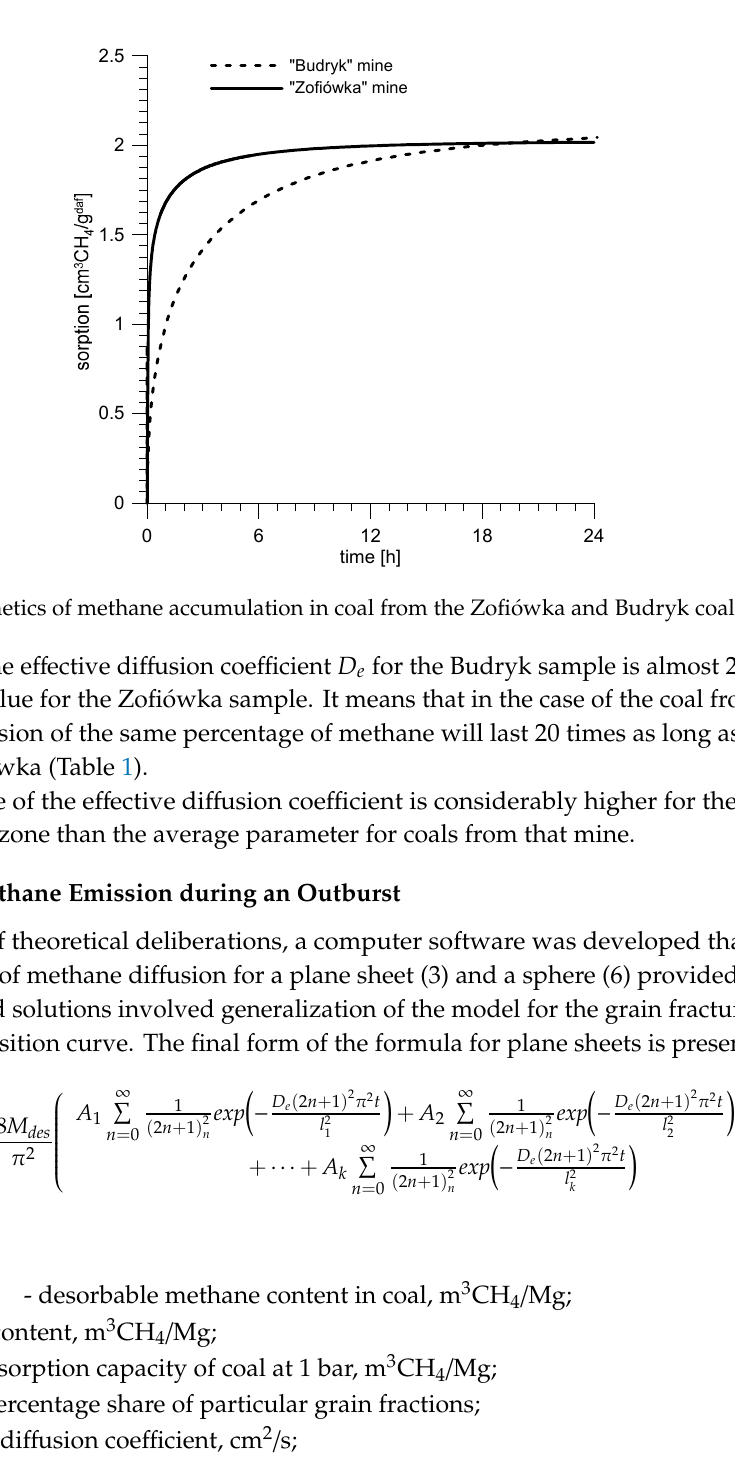
Figure 5. ( a ) Direct results of the sorption measurements—coal from the Budryk coal mine. ( b ) A sorption isotherm of the coal from the Budryk coal mine.